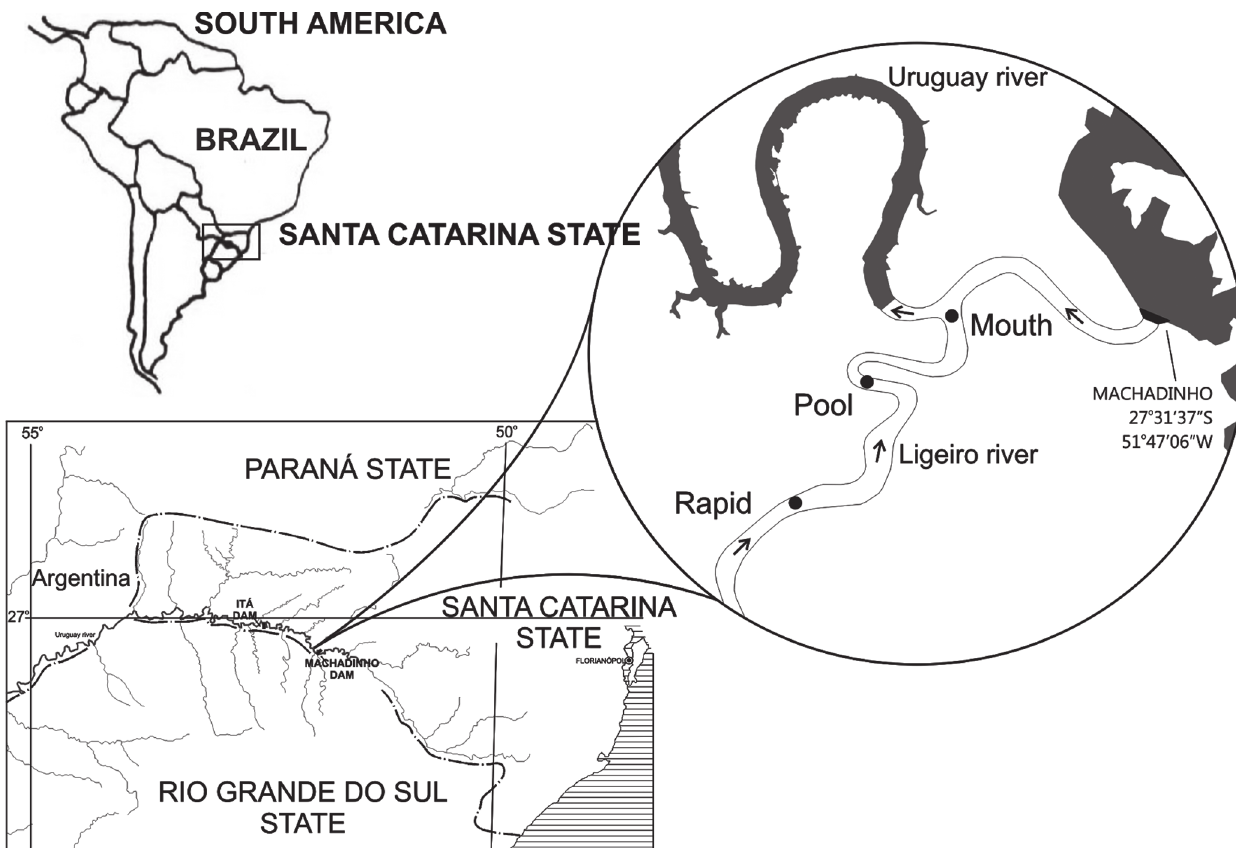
Fig. 1 . Sampling sites along the Ligeiro River. (  ) toward the river; (  ) sampling site; river region in gray represents the area of the